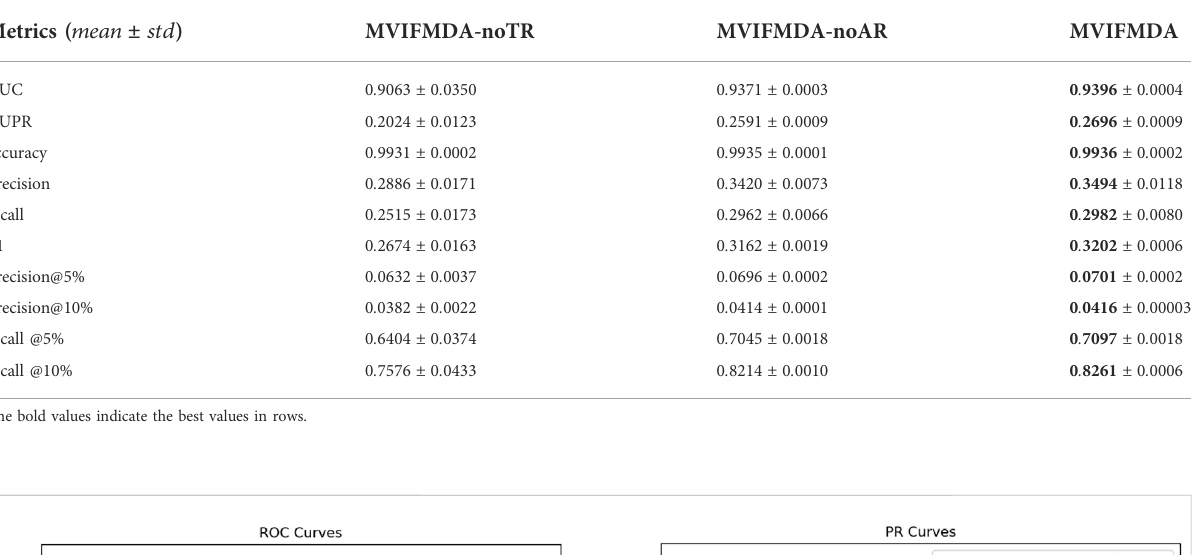
TABLE 1 Results of our model and its variant models.